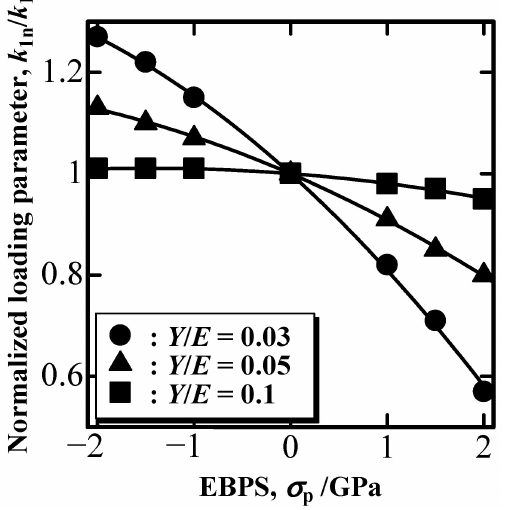
Figure 3. Normalized loading parameter, k 1n /k 1 , as a function of EBPS.